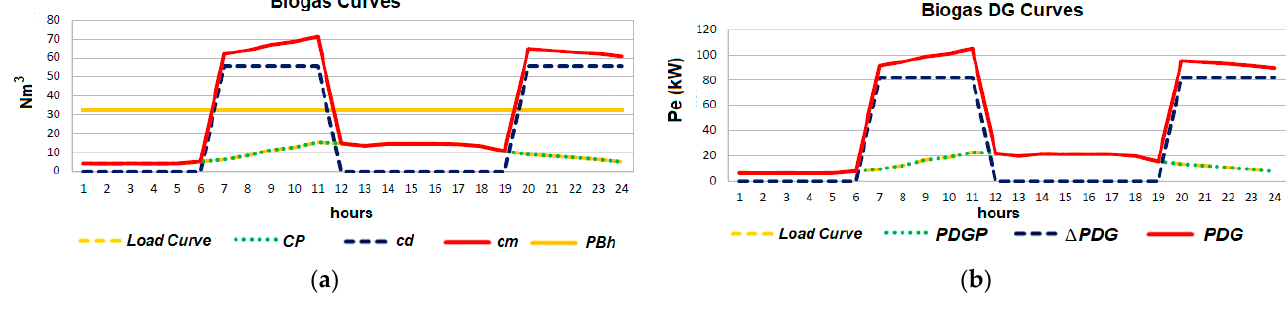
Figure 14. Case 5: ( a ) Biogas curves; ( b ) MOR from biogas DG.